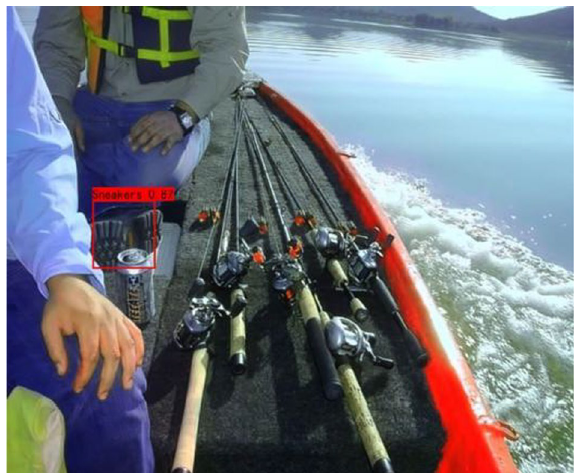
Fig. 13 Pseudo-RGB images 2(29th, 19th, and 9th spectrum)